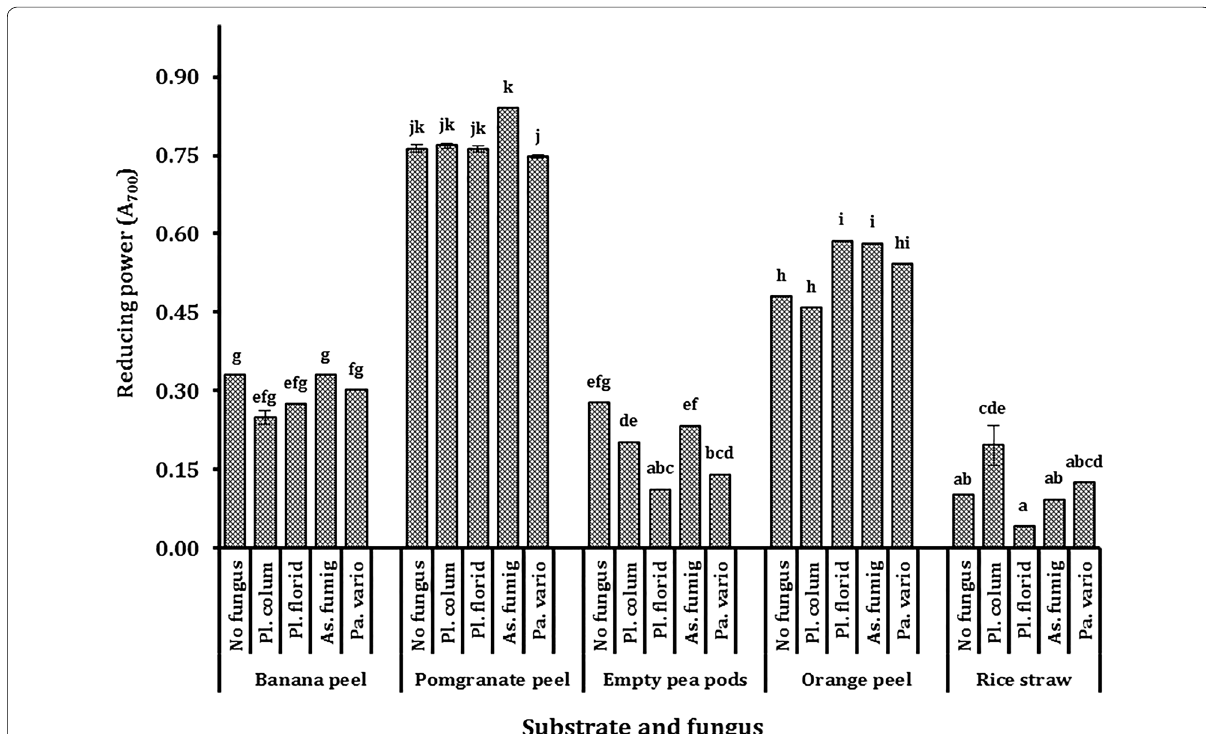
Fig. 3 Reducing power of an SSFS employing two basidiomycete fungi: P. columbinus and Pl. floridanus and two ascomycetes: A. fumigatus and P. variotii on peels of banana, pomegranate and orange, empty pods of pea and rice straw. Each column represents the mean of three replicates Columns with common letters are not significantly different at P <